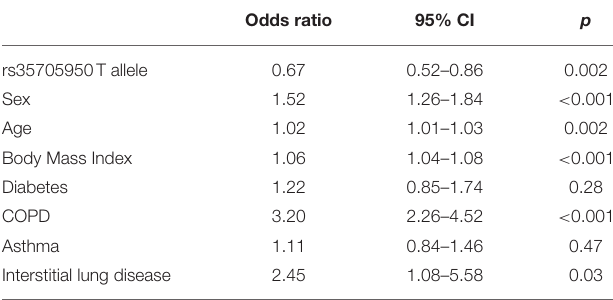
TABLE 4 | Multivariate association analysis for COVID-19 in the UK biobank validation